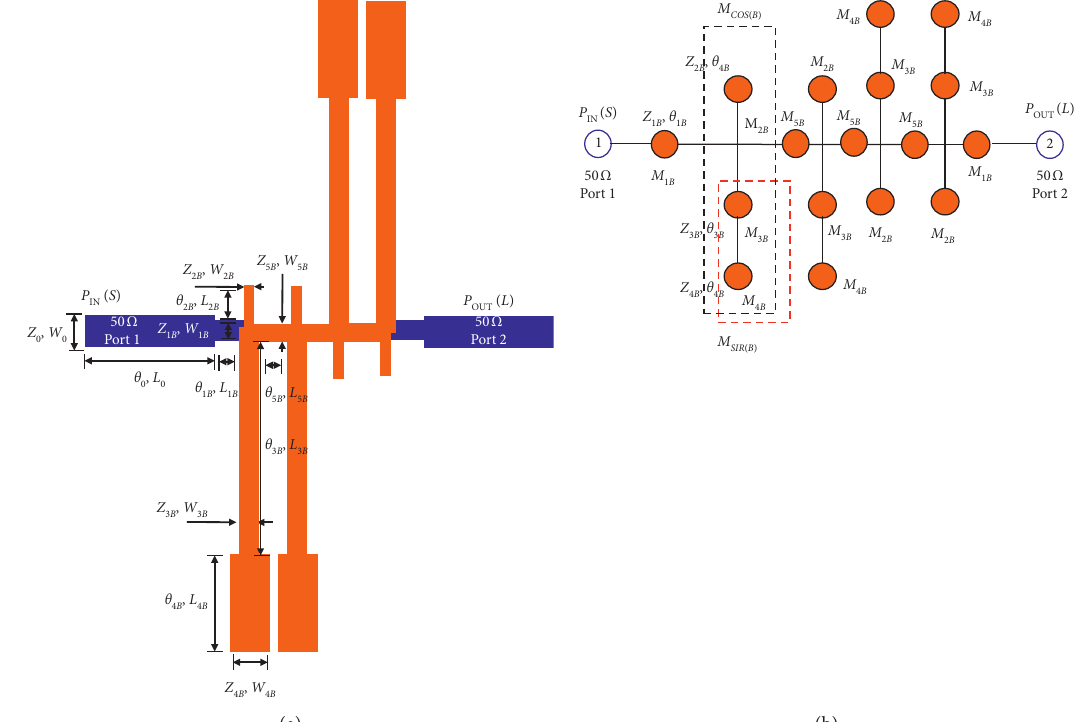
Figure 3: (a) QC-SSIR structure and (b) the ABCD matrix structure for the